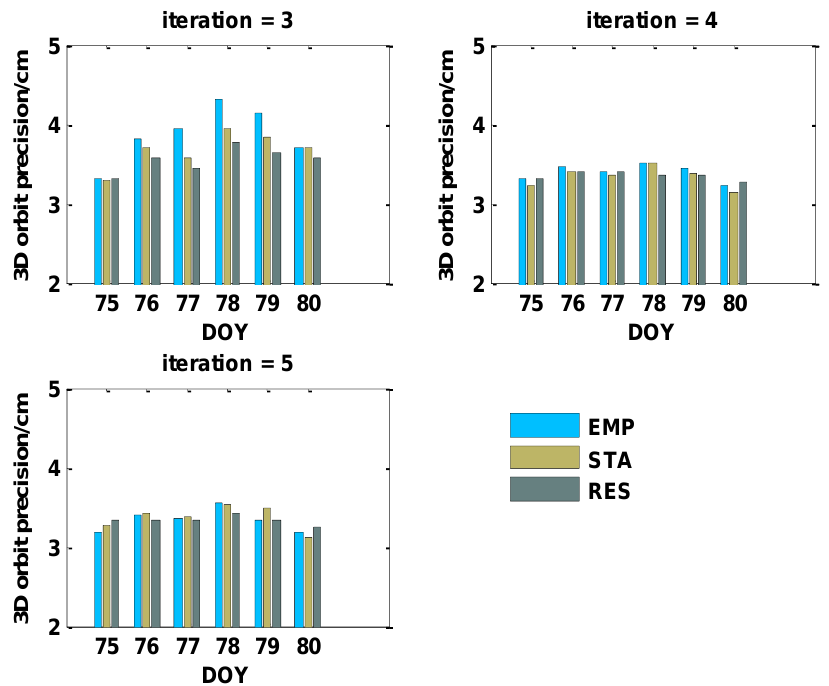
ment compared with that the EMP model.